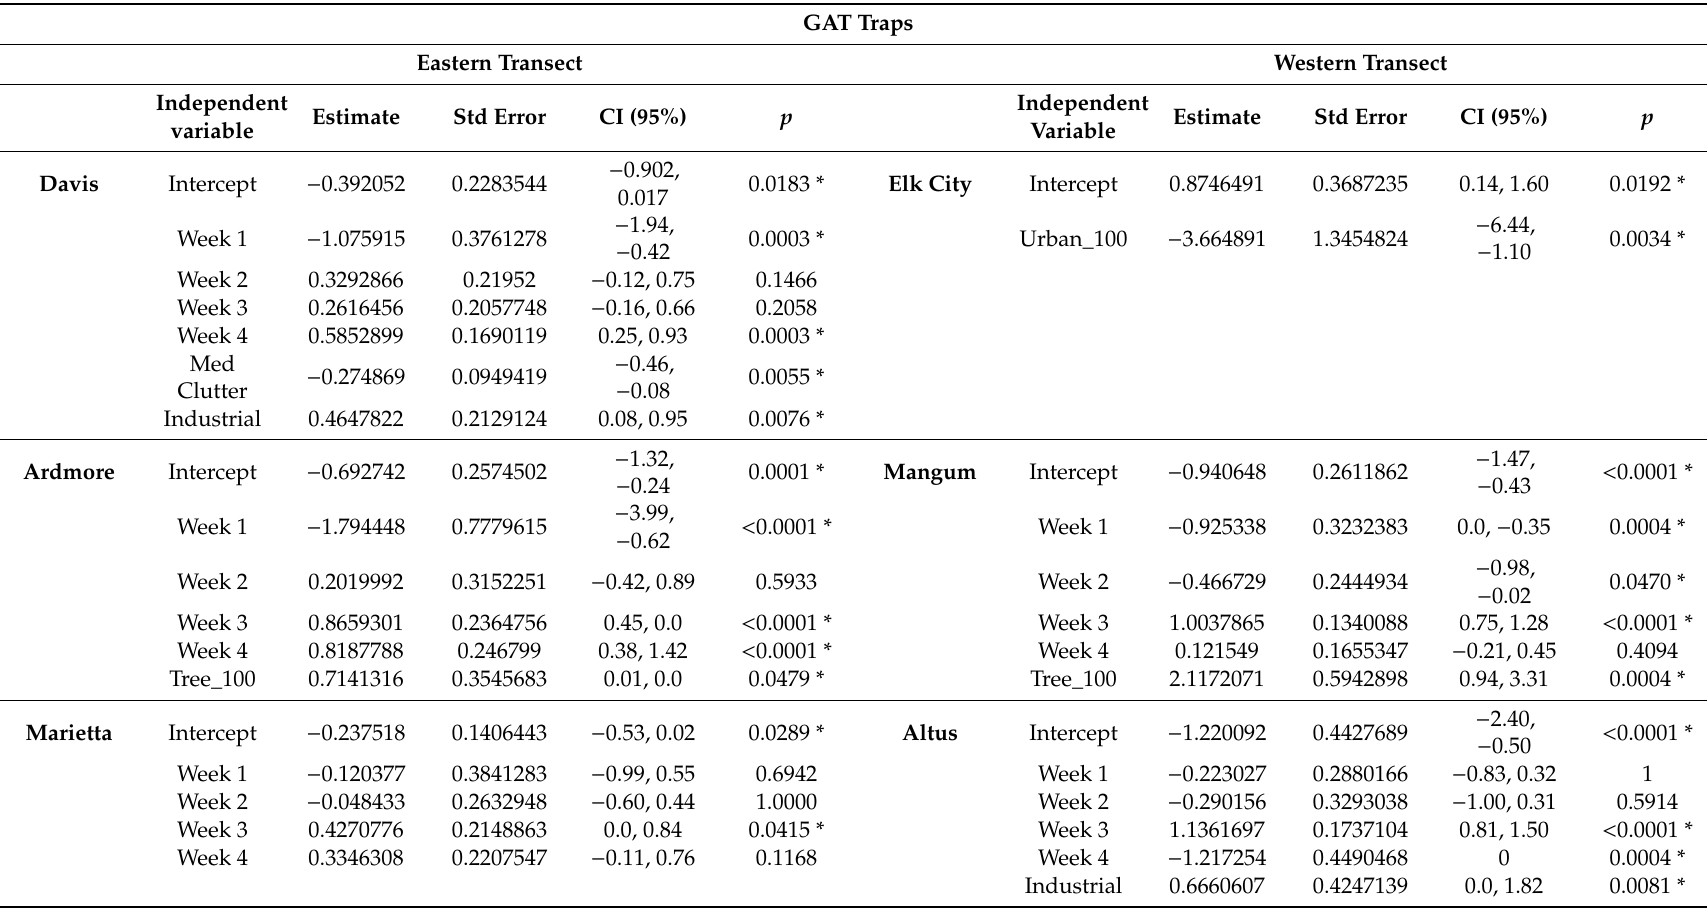
Table 5. Generalized linear model (GLM) analysis of mean abundance of Ae. albopictus by trap-night with landscape, spatiotemporal and anthropogenic variables between June and August